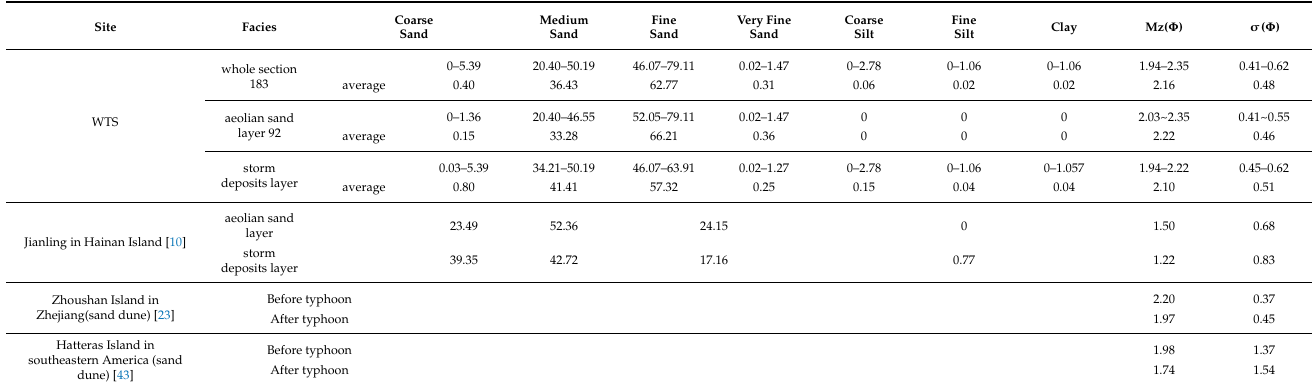
Table 2. Grain-size composition (%) of different sedimentary facies and main descriptive statistics (expressed in Φ units) in Wutou section and other